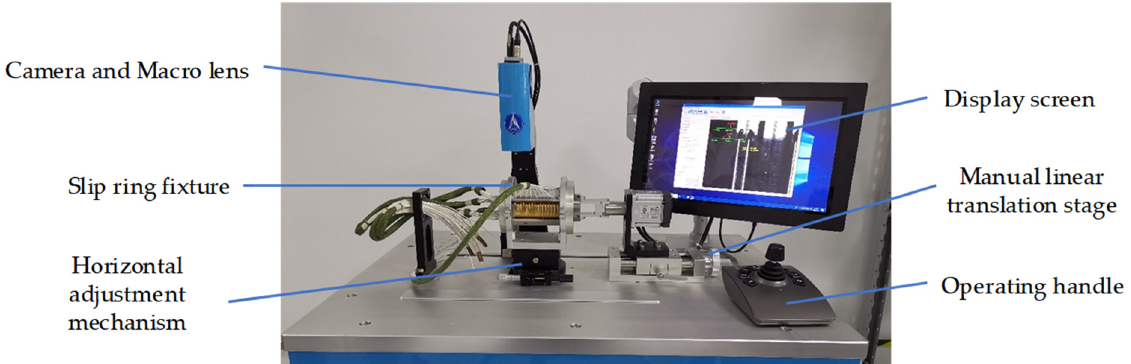
Figure 10. Developed vision-aided brush alignment assembly system.